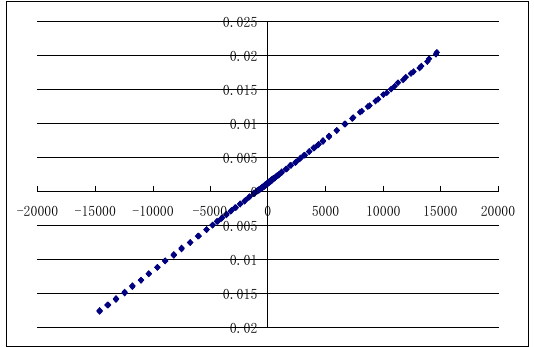
Figure 4. Room temperature M–H curves for Mn using roasting method,